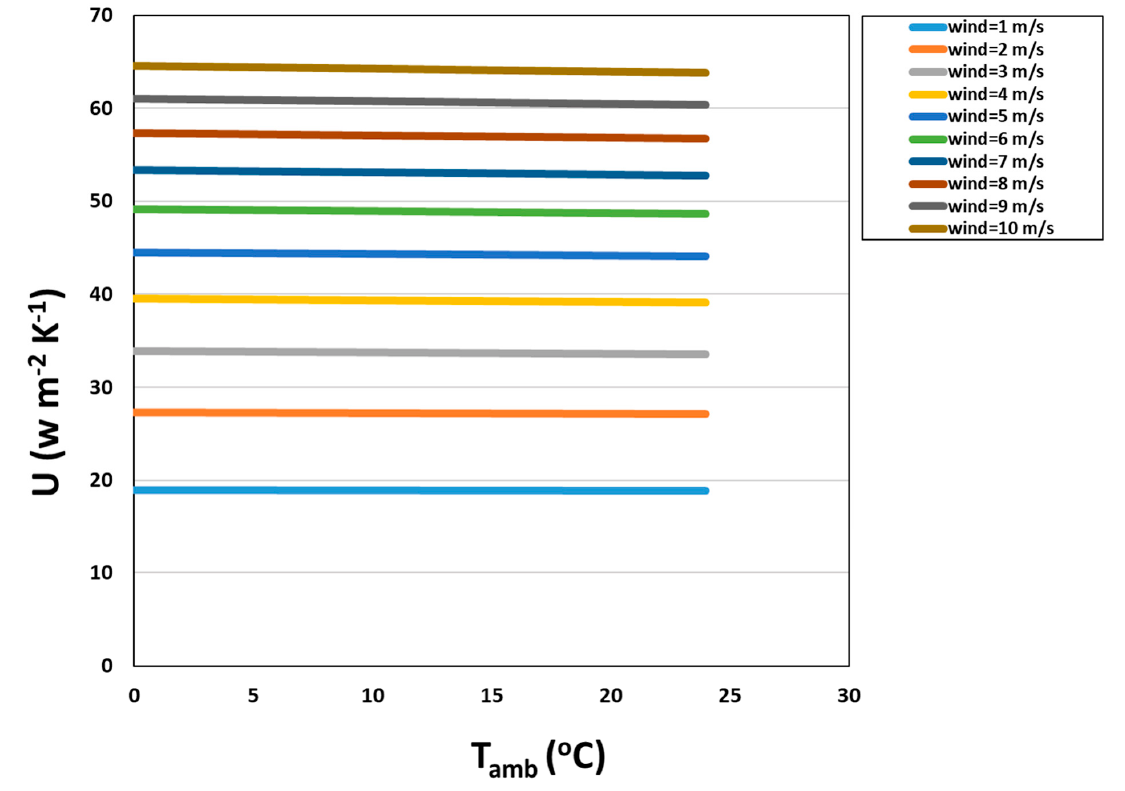
Figure 7. U (W m − 2 K − 1 ) vs. ambient temperature at a range of wind Figure 7. U (W m –2 K –1 ) vs. ambient temperature at a range of wind speeds.